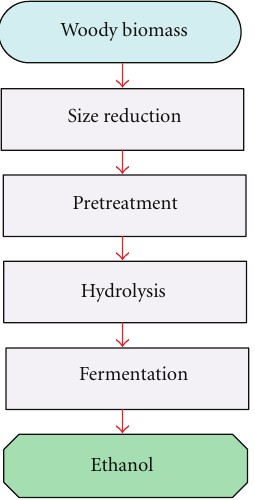
Figure 1: Major processes of converting woody biomass to ethanol (after [3]).